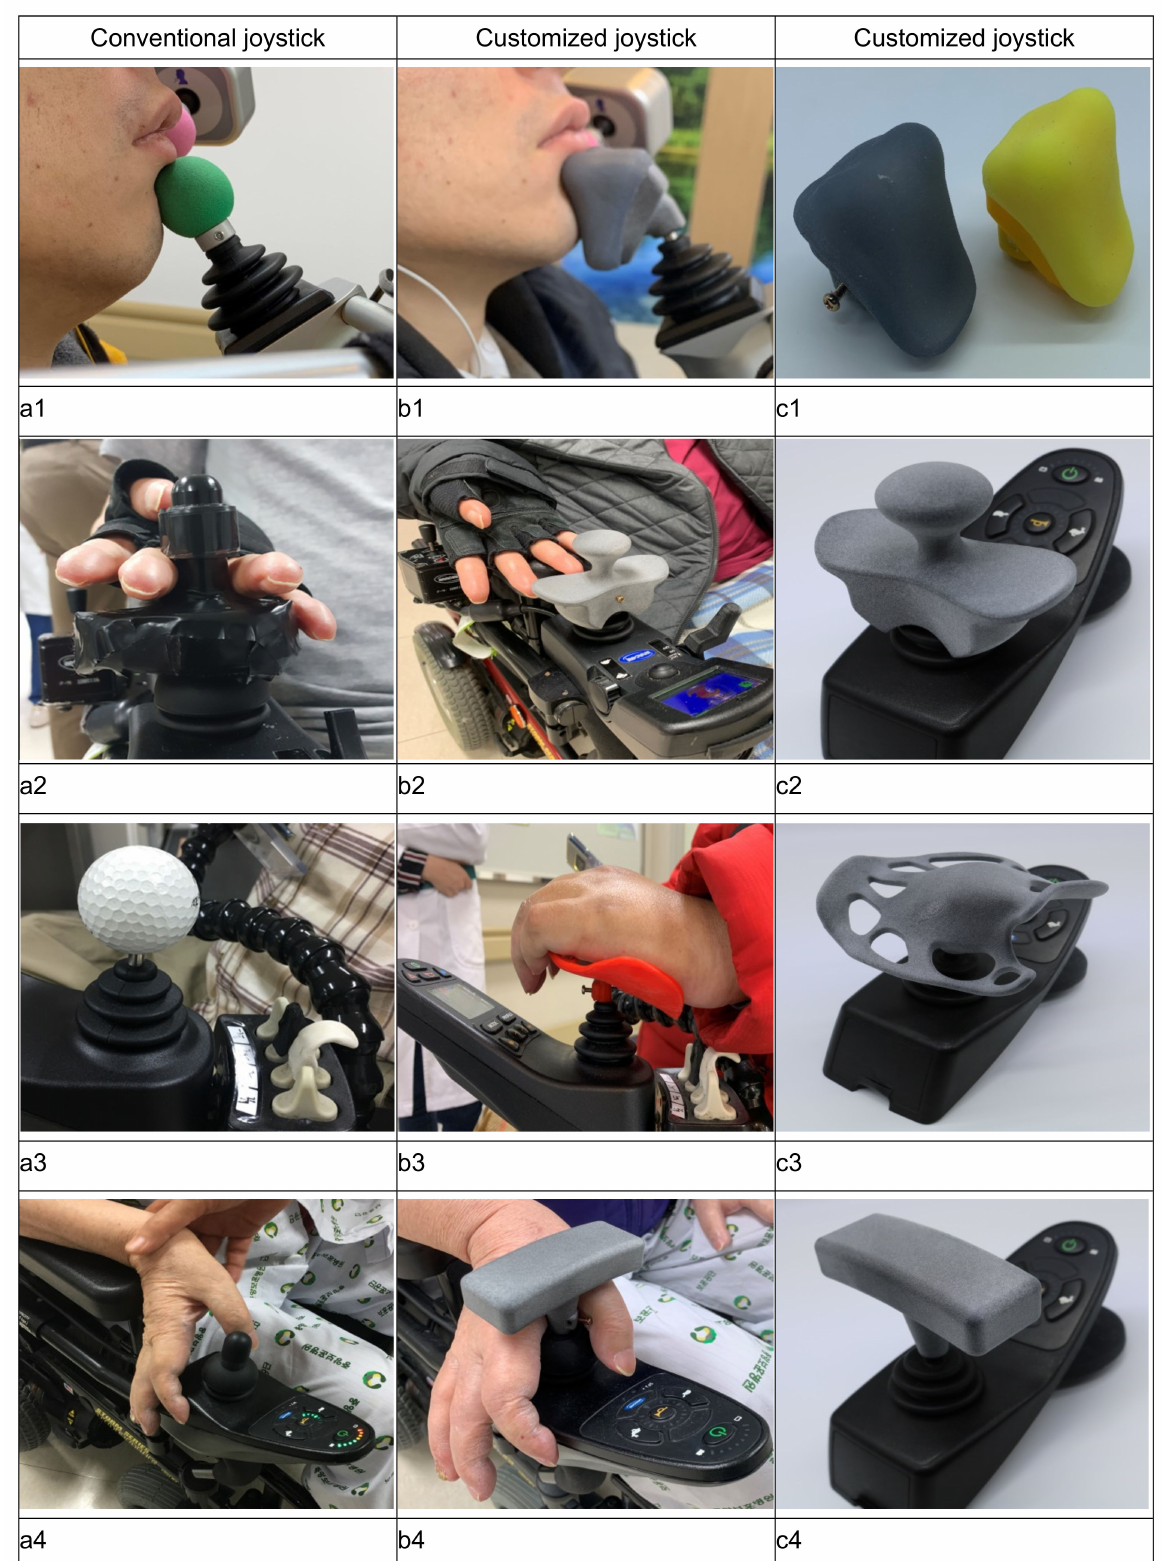
Figure 1. Joysticks employed in this study. ( a ) Conventional joystick. ( b ) Patient using the power wheelchair with a customized joystick. ( c ) Customized